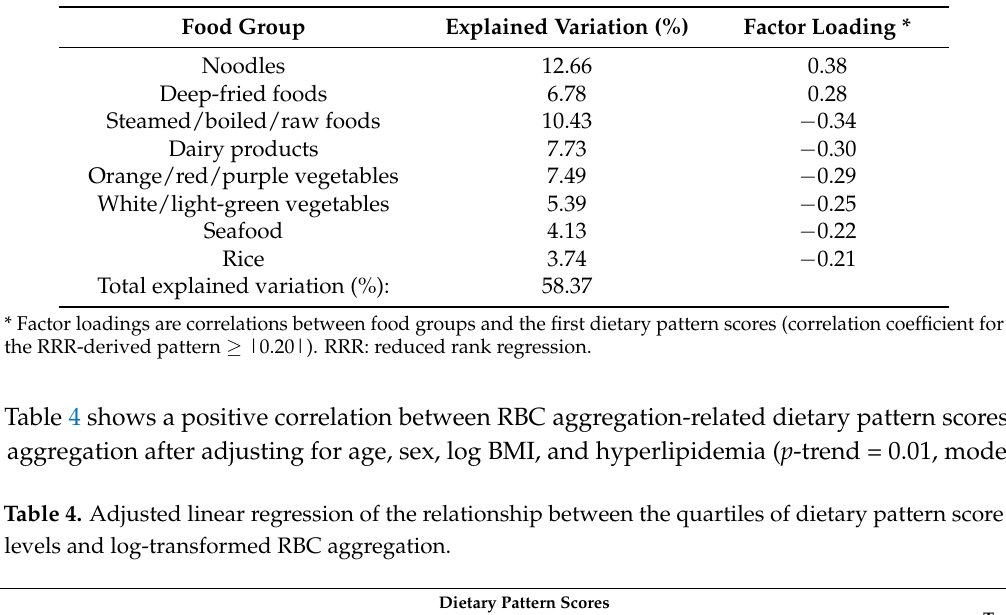
Table 3. Food groups which were strongly associated with RBC aggregation-related dietary pattern scores identified by using an RRR.